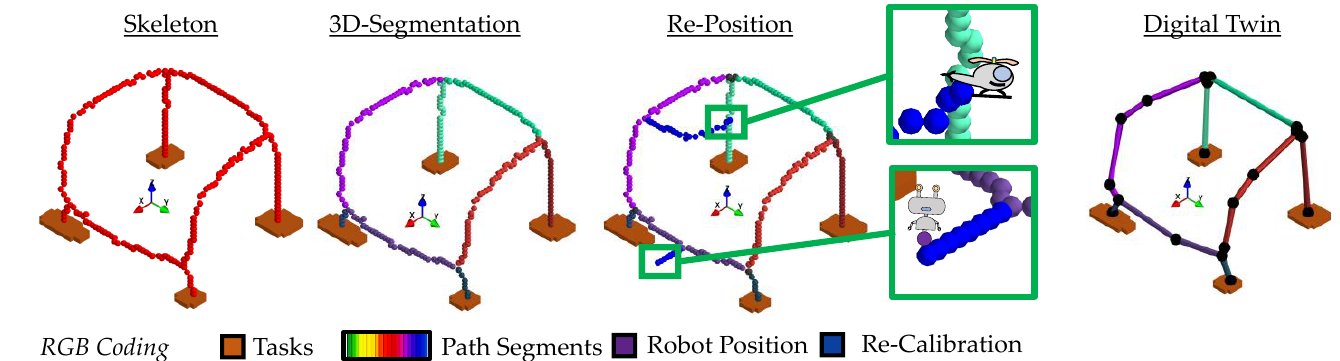
Figure 24. Generation of graphs for the 3D drone/robot sample: the skeleton of the 3D map, segmentation of the 3D skeleton, re-position of the off-track drone and robot, derived graph for digital twin.